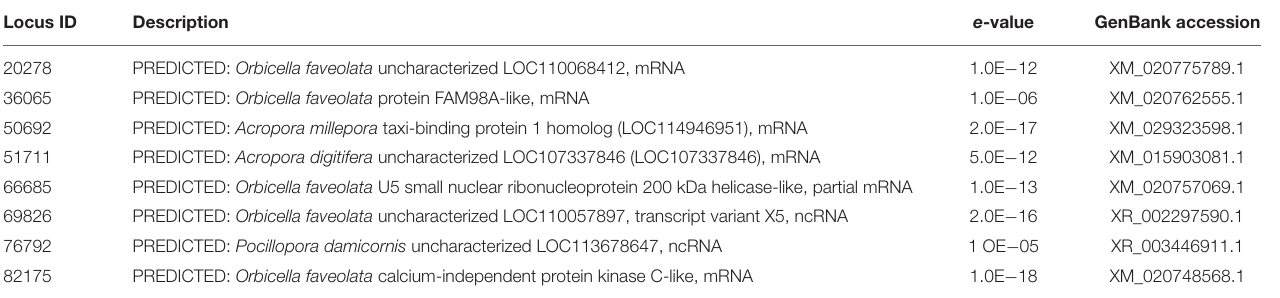
TABLE 1 | BLASTN hits for loci that were differentially methylated in at least two